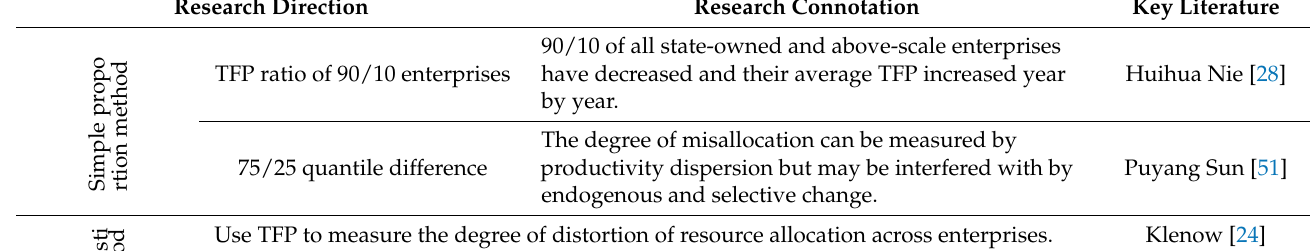
Table 6. Key literature for resource misallocation degree measurement and characterization. Research